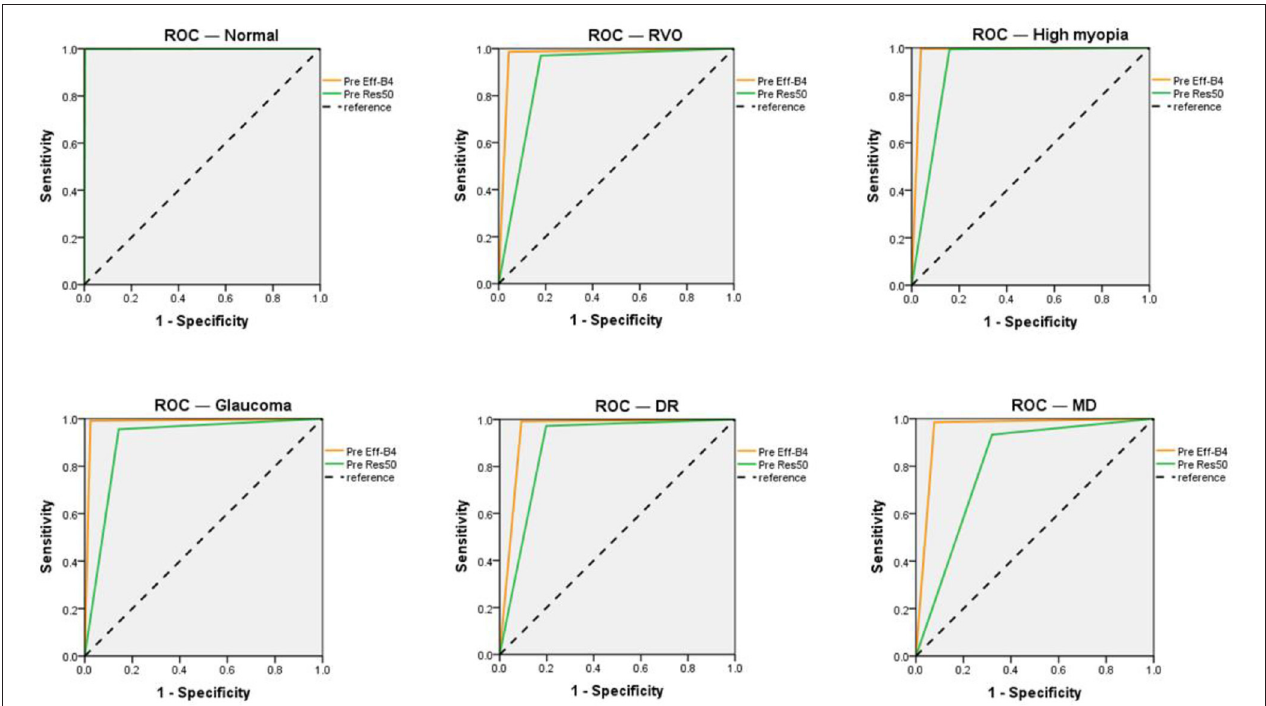
FIGURE 4 | ROC of the EfficientNet-B4 and ResNet 50-6 for normal fundus and the five common retinal